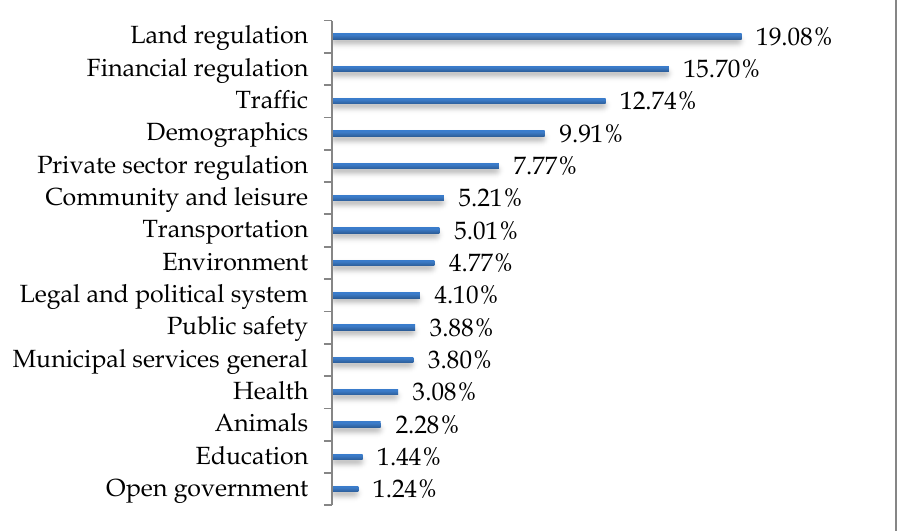
Figure 3: Distinct Metacategory Distribution